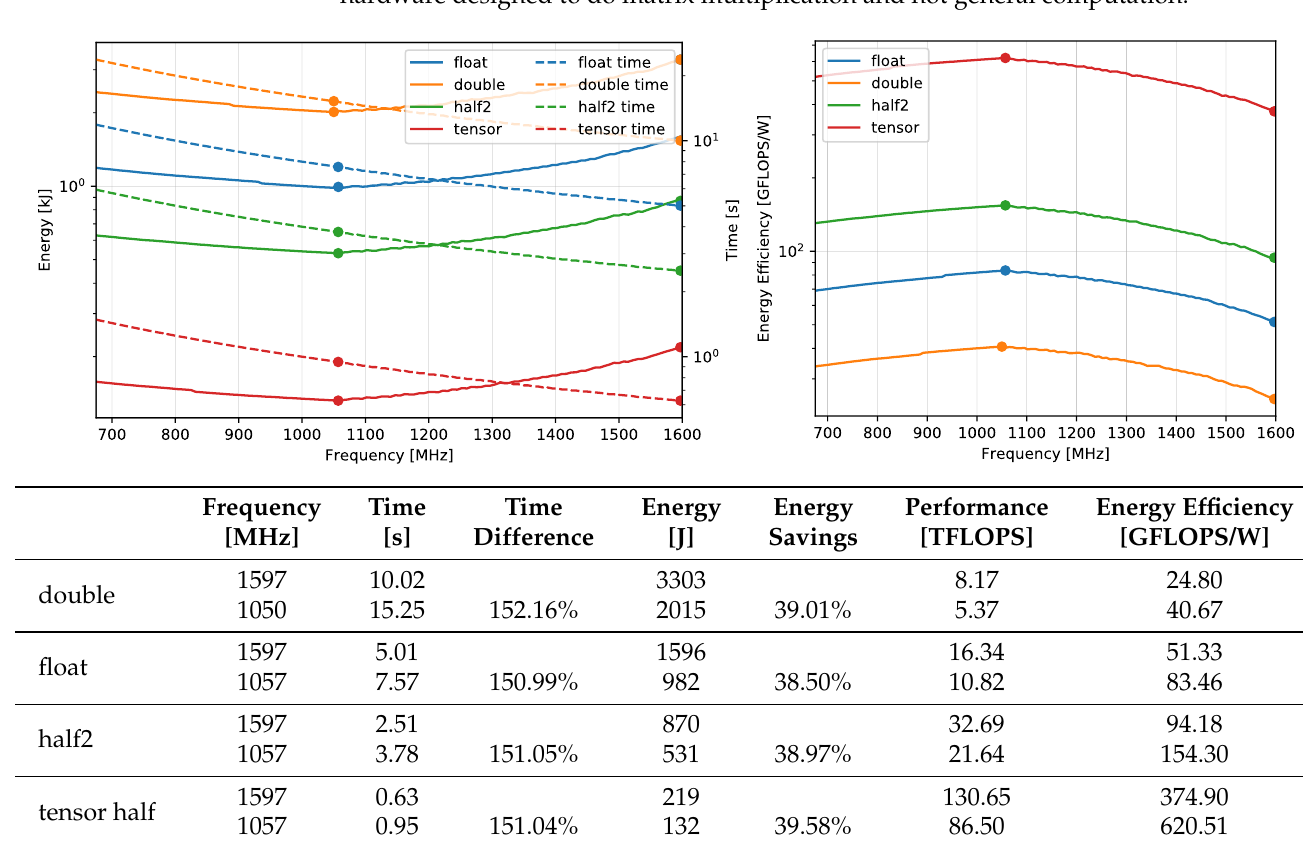
Figure 8. DGX-2 frequency scaling of Mandelbrot benchmark. The plot in the top left corner shows consumed energy and run-time of workload. The plot in the top right corner shows energy efficiency. The plots are in logarithmic scale. The table shows the time difference, energy savings, and energy efficiency of the Mandelbrot benchmark at the base and at the optimal frequency. The marker in the plot highlights the two frequencies from the